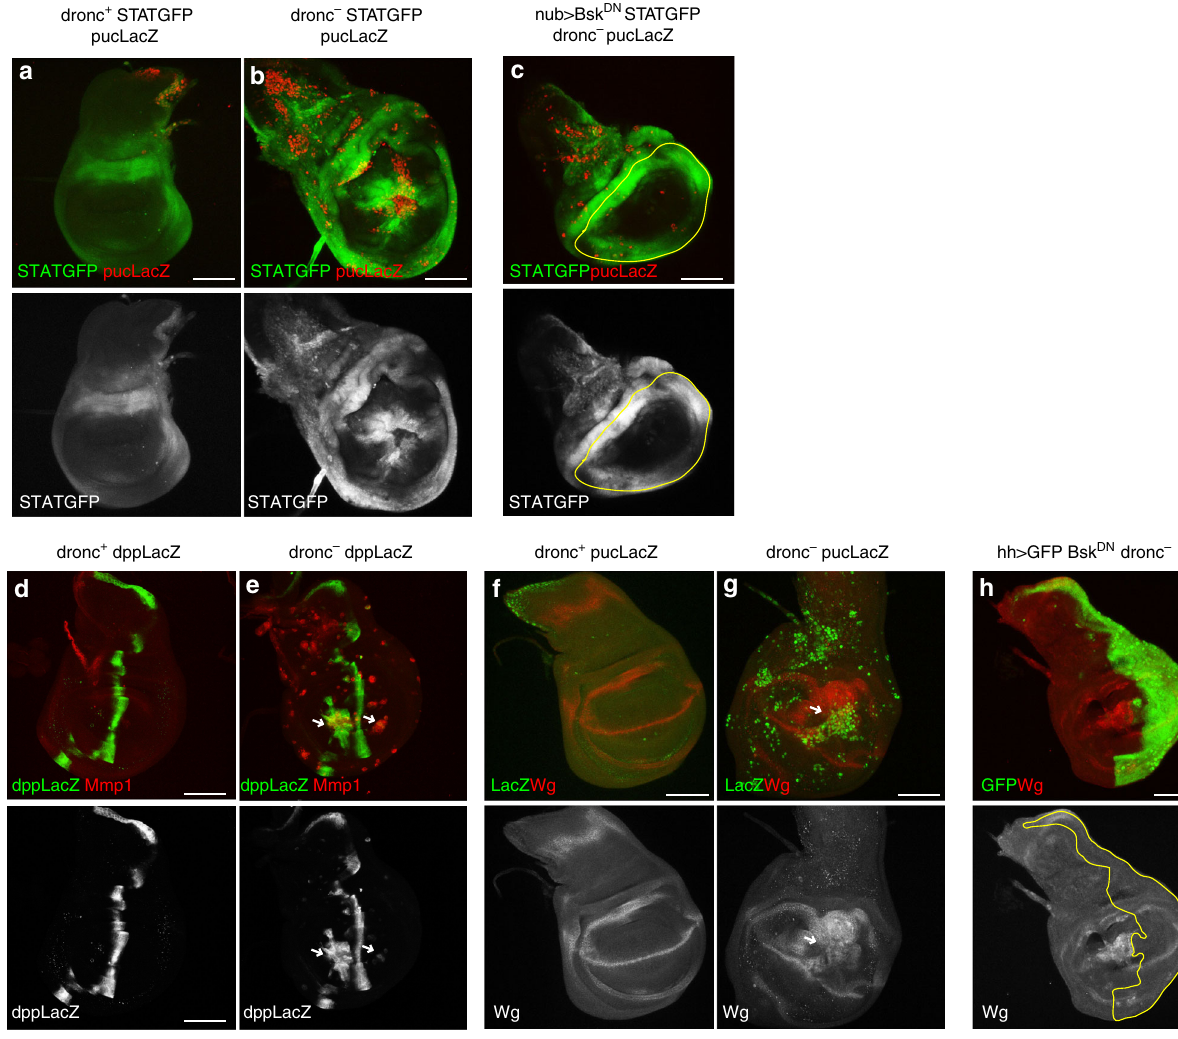
Fig. 3 JNK persistent activity induces sustained activity of the JAK/STAT, Dpp and Wg pathways. a – c Images of wing discs of genotypes: a STAT-GFP; pucLacZ dronc i24 / + ( n = 15), b STAT-GFP pucLacZ dronc i24 / dronc i29 ( n = 29), c UAS-Bsk DN ;nub-Gal4/STAT-GFP ; puc-lacZ dronc i24 / dronc i29 ( n = 3), 96 h after irradiation stained for STAT-GFP (green) and β -gal (red). Note in b the ectopic STAT expression, especially in the wing pouch, associated with ectopic JNK activity. In c , the suppression of JNK, achieved by forcing bsk DN in the wing pouch (the domain of nubbin outlined in yellow), prevents ectopic STAT expression. d , e Images of wing discs of genotypes: d dpp-LacZ;dronc i24 / + ( n = 14) and e dpp-LacZ;dronc i24 /dronc i29 ( n = 17) 96 h after irradiation; dpp expression is monitored by a LacZ insert at the dpp locus ( dpp-LacZ , green) and JNK function is indicated by Mmp1 staining (red). The dronc + disc ( d ) shows wildtype dpp pattern, whereas in dronc − ( e ) there is ectopic dpp expression (arrows) associated with Mmp1 cells. f , g Images of wing discs of genotypes: f pucLacZ dronc i24 / + ( n = 9), g puclacZ dronc i24 /dronc i29 ( n = 22) 96 h after irradiation, stained with anti-Wg antibody (red) and puc-LacZ (green) to label JNK activity. The wg expression pattern is normal in dronc + ( f ), but in dronc − , there is clear ectopic expression ( g ), especially in the wing pouch (arrow). Note the overall coincidence between the zones of ectopic wg expression and of JNK activity. And h UAS-bsk DN ;UAS-GFP;puc-lacZ dronc i24 / hh-Gal4dronc i29 ( n = 8) 96 h after irradiation, stained with anti-Wg antibody (red), the suppression of JNK activity by bsk DN in the posterior compartment (green) prevents ectopic wg expression. Scale bars are 100 μ